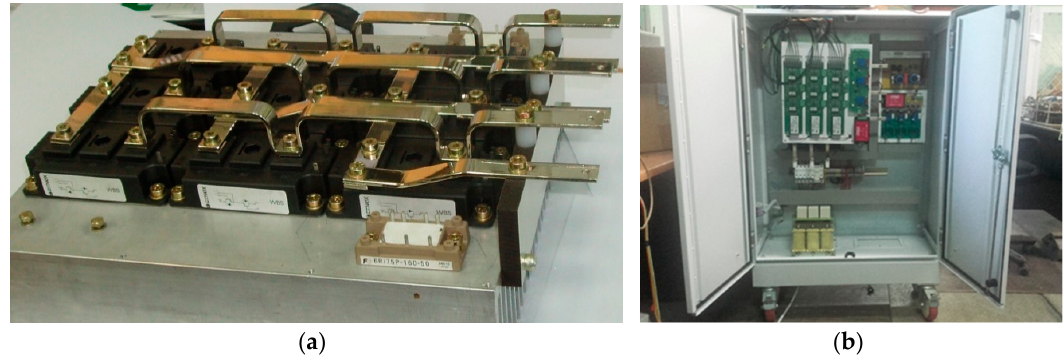
Figure 6. MC construction: ( a ) Dynex 1.2 kV/200 A IGBT; ( b ) a built-in MC structure in the control cabinet.